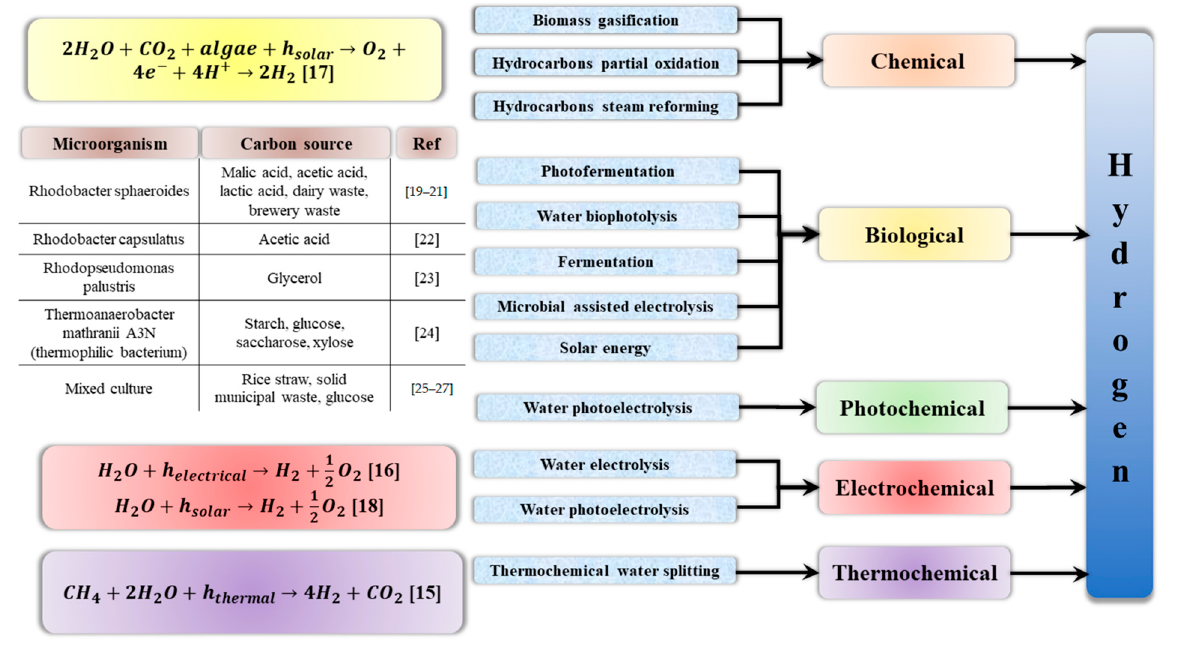
Figure 3. Types of methods for obtaining hydrogen [15–28].